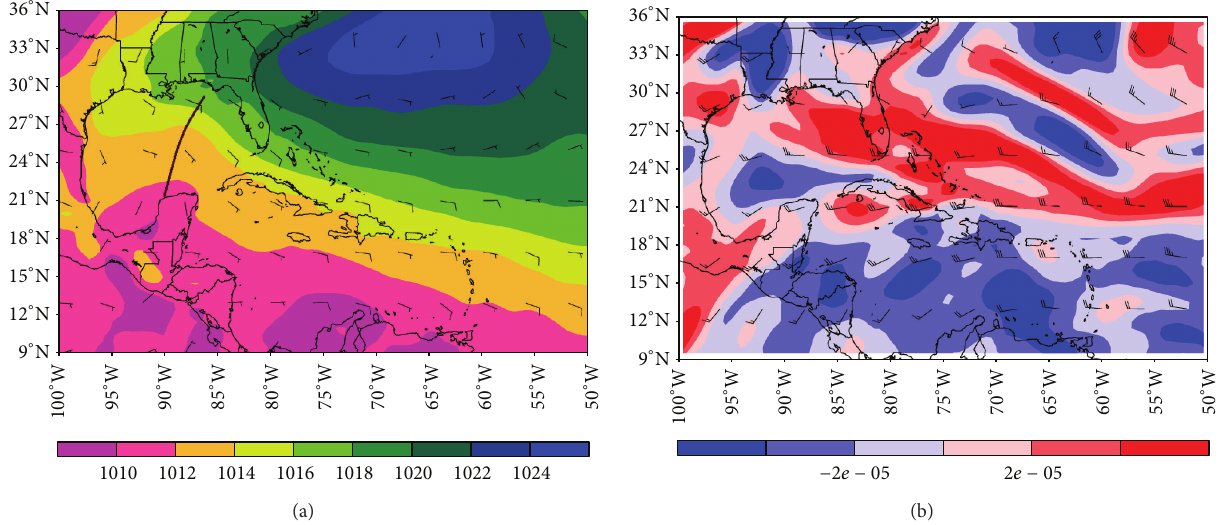
Figure 3: Era Interim data valid for 1800 UTC on 1 May 2012. (a) Sea level pressure (shaded) and wind field (barbs) at 850 mb. (b) Vorticity (shaded) and wind field (barbs) at 200 mb. The brown line over the Gulf of Mexico in (a) represents a trough.